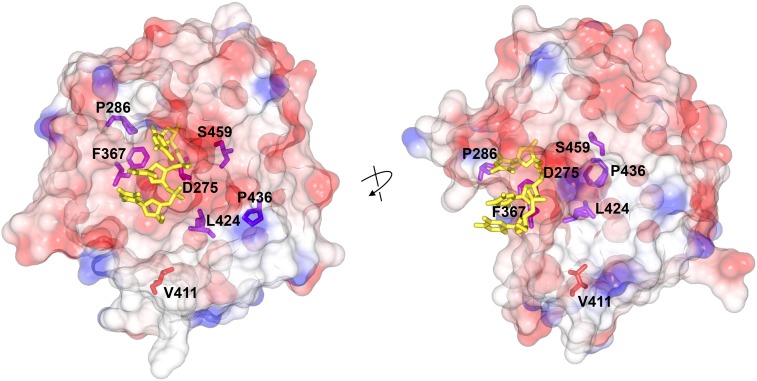
Location of cancer-associated Polε mutations within the exonuclease domain. Structure of the exonuclease domain of Saccharomyces cerevisiae Polε (PBD ID: 4M8O) is from Hogg et al. (2014). Single-stranded DNA (yellow) was modeled in the exonuclease active site by alignment with the structure of T4 polymerase–DNA complex (PBD ID: 1NOY) as done previously (Rayner et al. 2016). The protein surface is colored according to electrostatic potential, revealing the predominantly negatively charged exonuclease active site cleft. Two views of the same structure are shown, with the arrow indicating the approximate direction of rotation. Note the clustering of six cancer-associated mutations at the active site cleft (side chains shown in purple sticks) and the distant position of V411 (red sticks). The figure was generated with CCP4MG molecular graphics software.